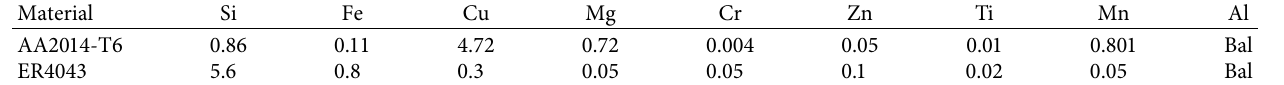
Table 1: Chemical composition (wt-%) of the AA2014-T6 aluminum alloy and ER4043 filler wire. Material